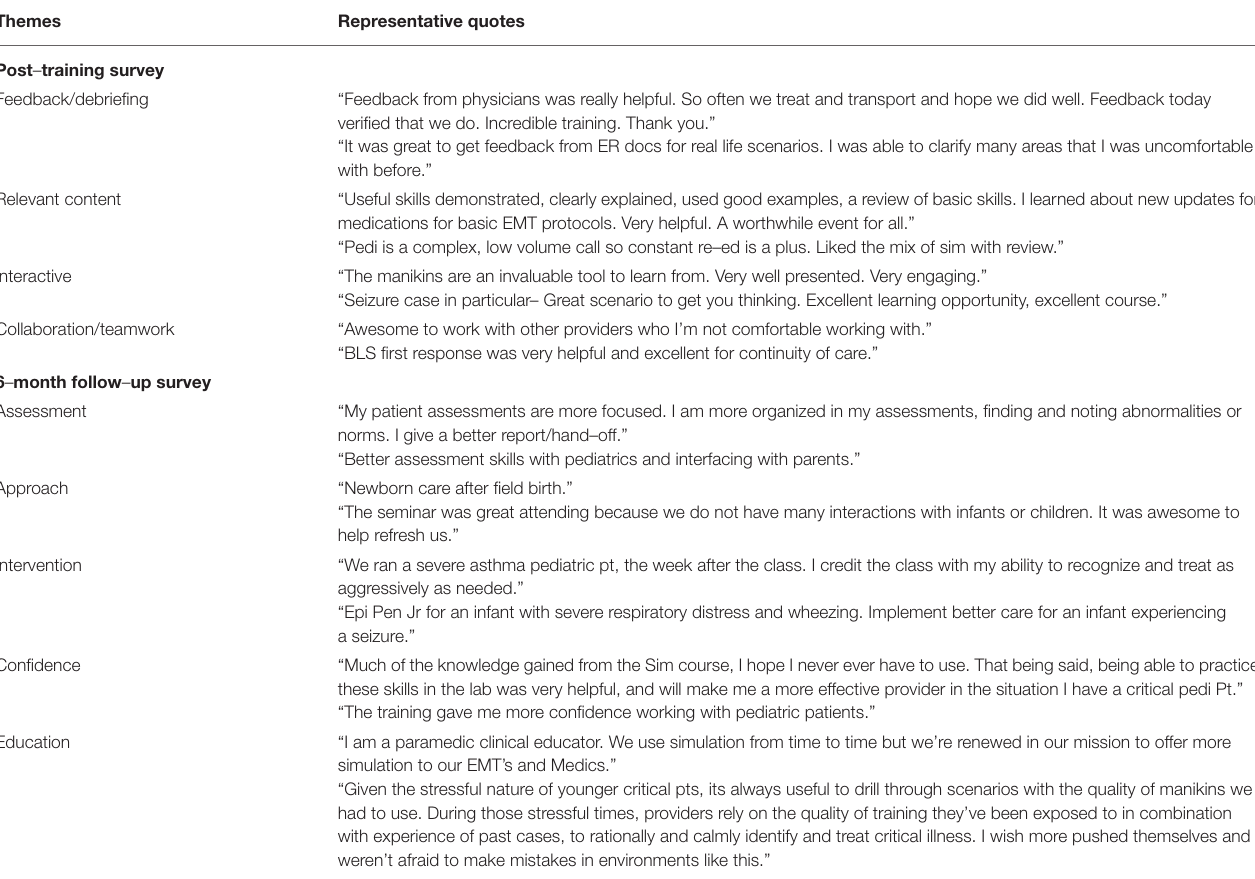
TABLE 3 | Qualitative themes